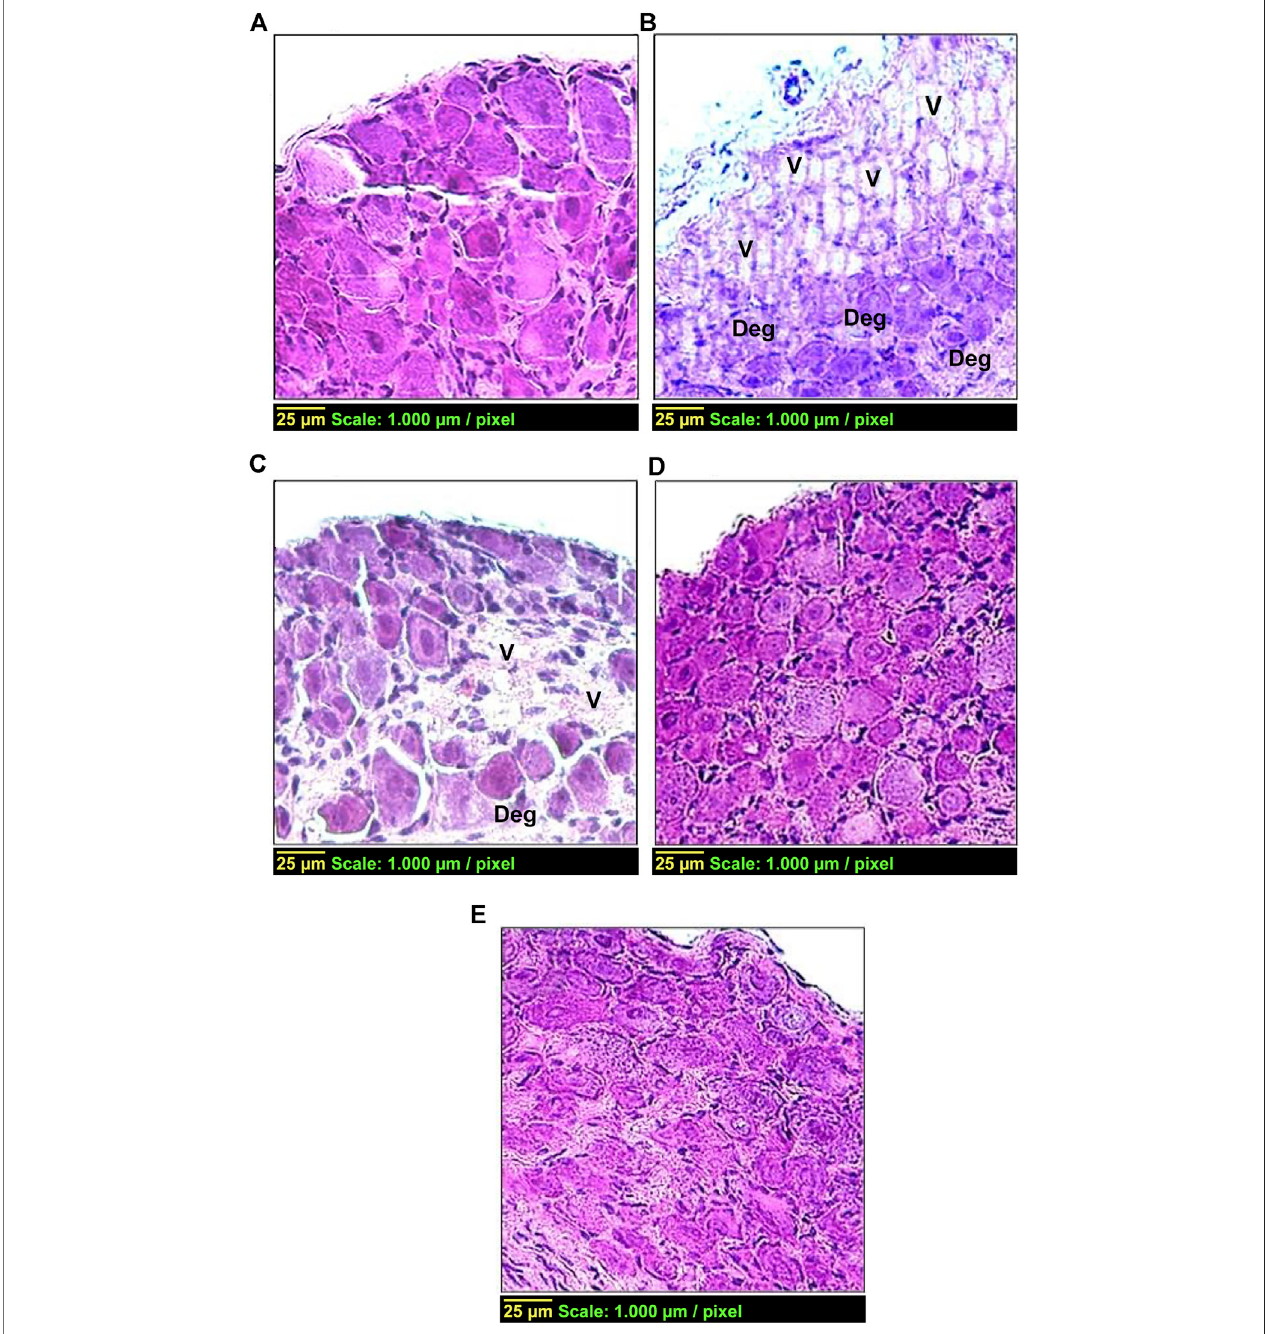
FIGURE 5 | Effect of carvedilol on histopathological changes in the DRG tissue in STZ-induced diabetes in rats. (A) Control group with normal architecture. (B) Diabetic group with vacuolization ‘ V ’ (++++) and degeneration ‘ Deg ’ (++++) of the DRG tissue. (C) Diabetic rats treated with carvedilol (1 mg/kg/d) showing a lesser degreeofpathologicalchangesintheDRGtissue; ‘ V ’ +++and ‘ Deg ’ +++. (D) Diabeticratstreatedwithcarvedilol(10 mg/kg/d). (E) Diabeticratstreatedwith a -lipoicacid (100 mg/kg/d). Of note, both D and E had minimal pathological changes in the DRG tissue compared with the diabetic group.